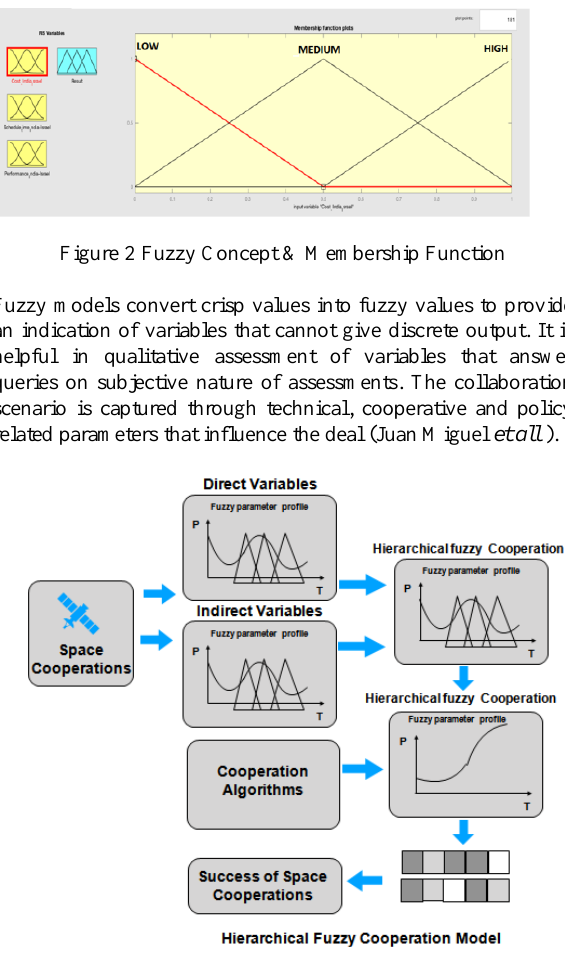
Fig.-3 Flow chart of Fuzzy Model implemented for assessment of space